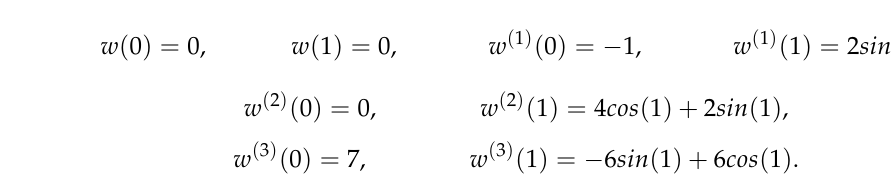
Table 8. Comparison of exact solution and Cubic B-spline solution of Problem 3 at h = 1